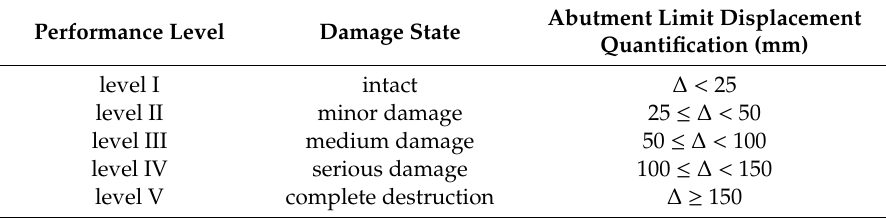
Table 6. Division of damage states of the abutments.